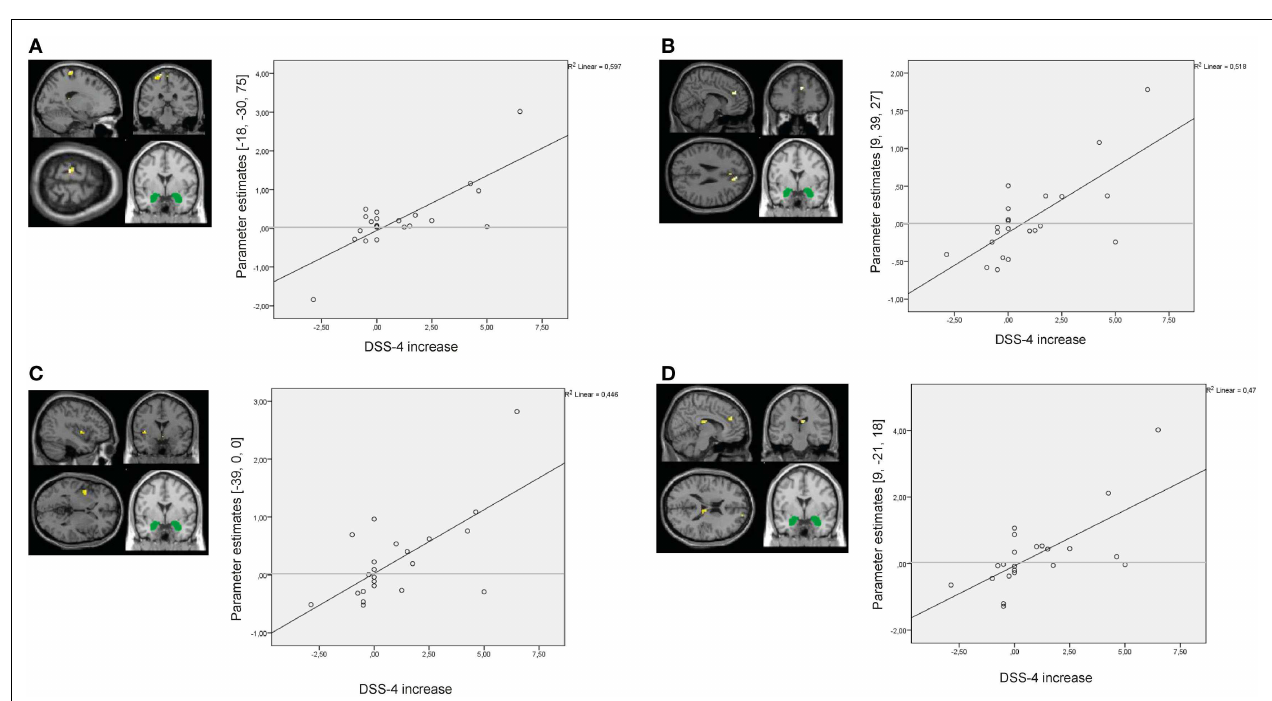
amygdala connectivity with left precentral gyrus (MNI: − 18, − 30, 75). (B) Regression for amygdala connectivity with right anterior cingulate cortex (9, 39, 27). (C) Regression for amygdala connectivity with left insula ( − 39, 0, 0). (D) Regression for amygdala connectivity with right thalamus (9, − 21, 18). DSS-4, Dissociation Stress Scale